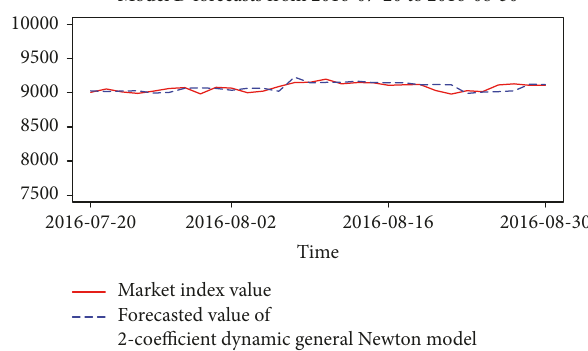
Figure 14: Time plots of raw data and the forecasts of model A.